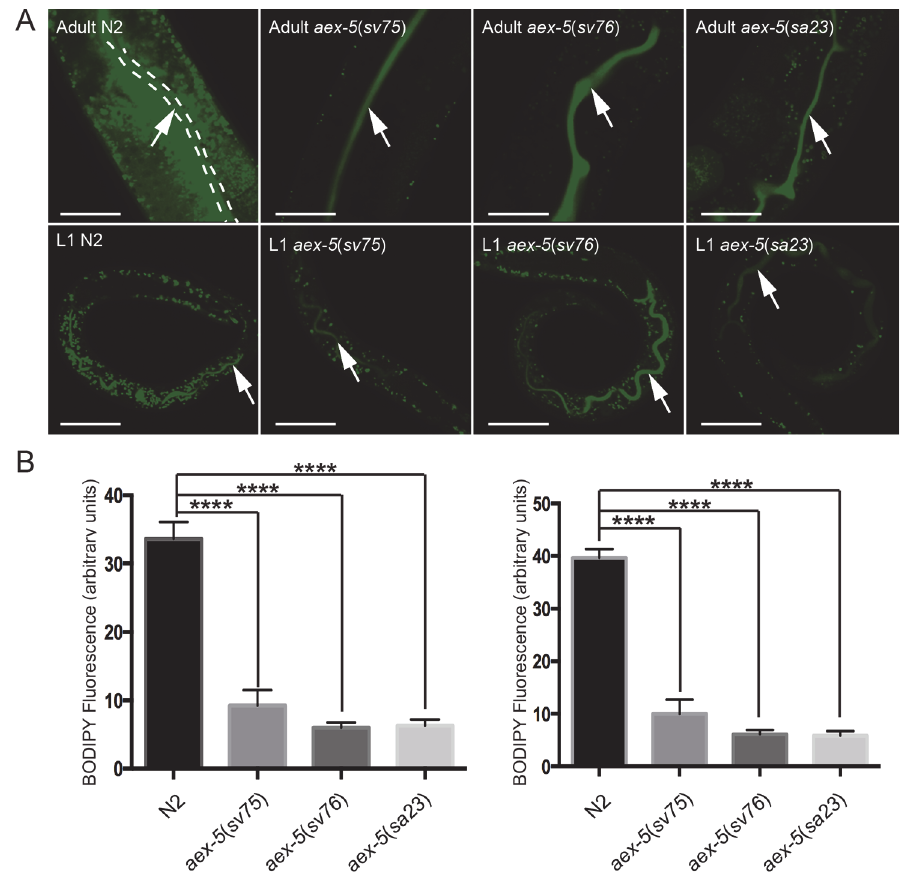
Fig 5. aex-5 mutants take up a fluorescently labelled fatty acid derivative from the intestinal lumen less efficiently than wild type. A. Confocal fluorescence micrographs of worms fed the fluorescently labelled fatty acid derivative C 1 -BODIPY 500/510 C 12 . The panels at the top show parts of the intestines of adult worms; those at the bottom show first larval stage (L1) worms. The arrows point to the intestinal lumen where most of the dye is found in the mutants. Scale bars are 20 μ m. B. Graphs showing quantification (in arbitrary units) of the uptake of the dye into the cytoplasm of intestinal cells (Materials and Methods). Error bars indicate standard errors of the means. **** indicates significant difference in the means determined by one-way ANOVA and Dunnett's multiple comparisons test ( σ = 0.05).